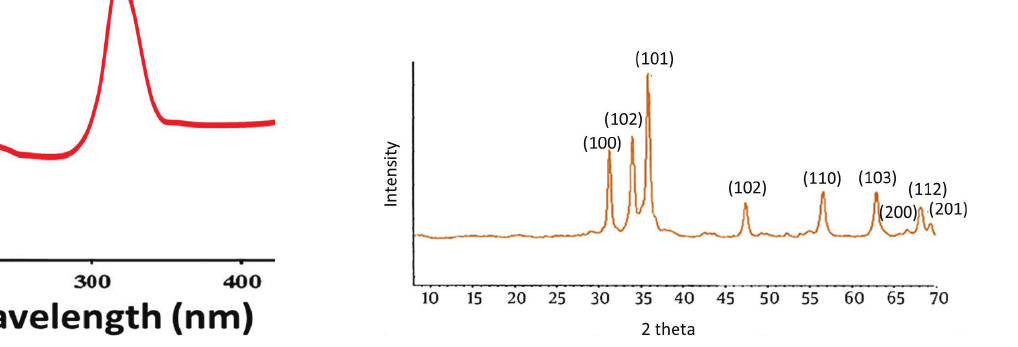
Figure 2: Fluorescence studies of zinc oxide NPs.